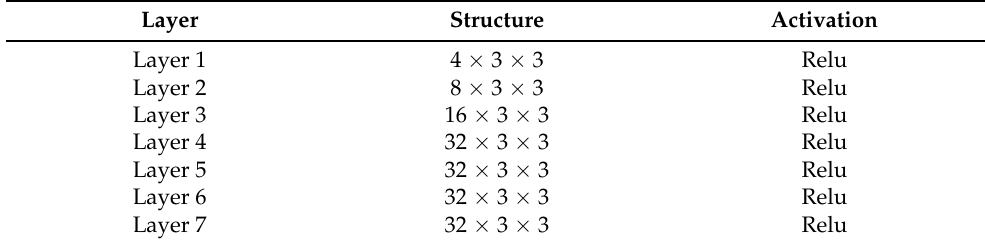
Table 1. Vehicle matching network—each branch’s structure. Layer